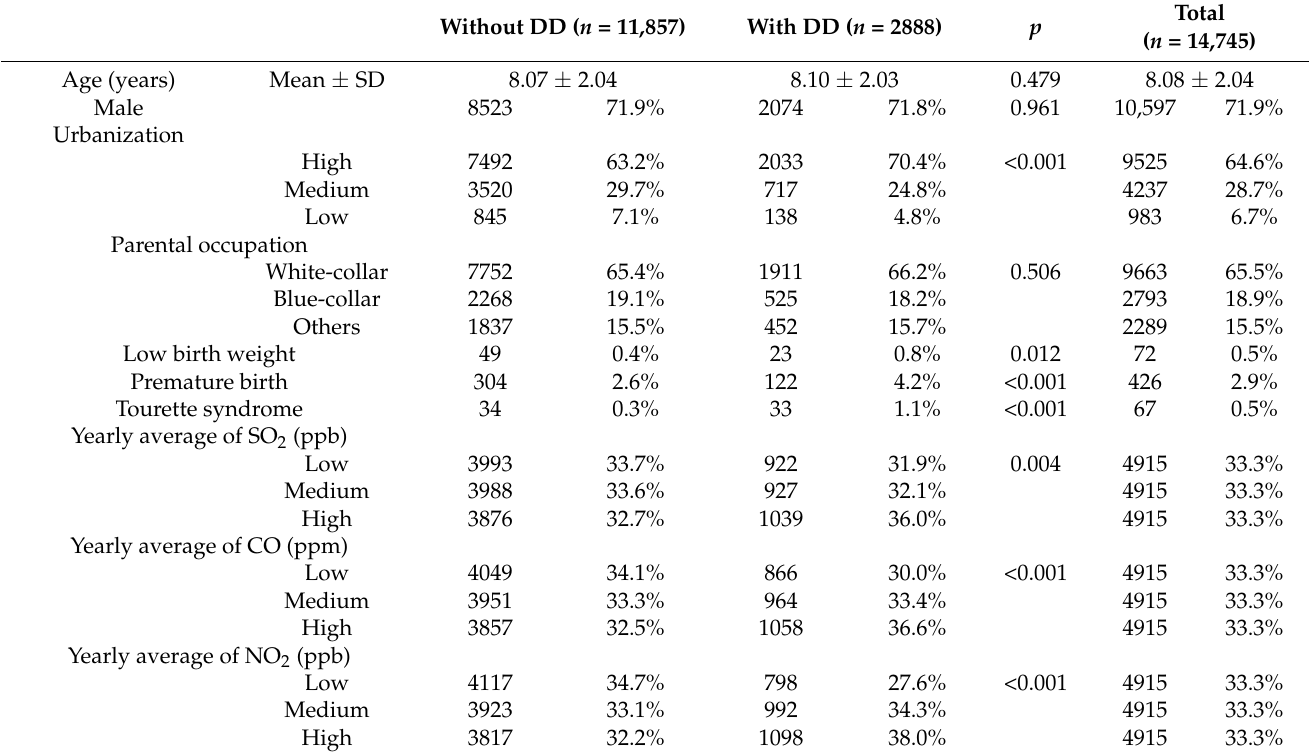
Table 1. Distribution of demographic data among the study population.